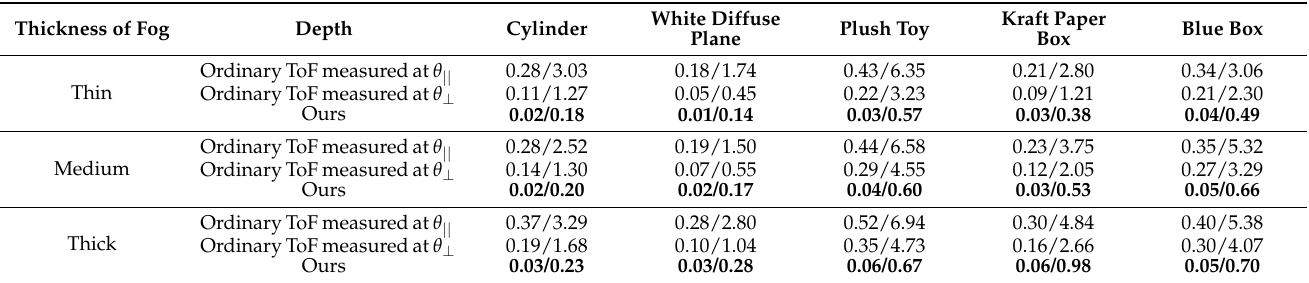
Table 2. Quantitative evaluation of depths using the mean absolute error and mean squared error (MSE). Each cell shows the mean absolute error